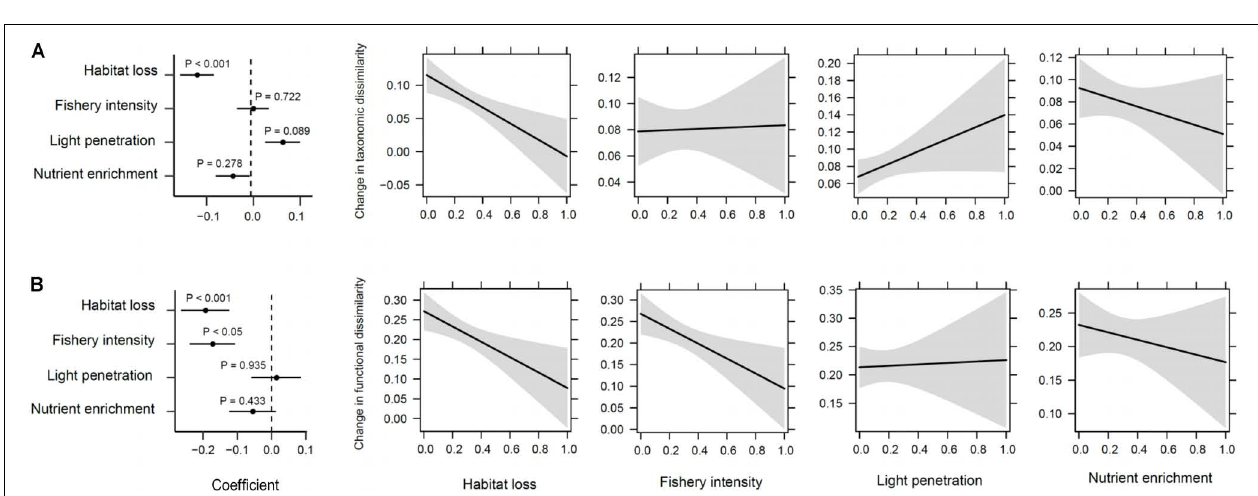
FIGURE 7 | Human impacts on changes of macrophyte richness. (A) Taxonomic and (B) functional richness patterns showing from left to right the correlation coefficients and their significance from a generalized linear model, and the estimated marginal effects and confidence intervals of human impacts (i.e., habitat loss, fishery intensity, light penetration, and nutrient enrichment in sequence).